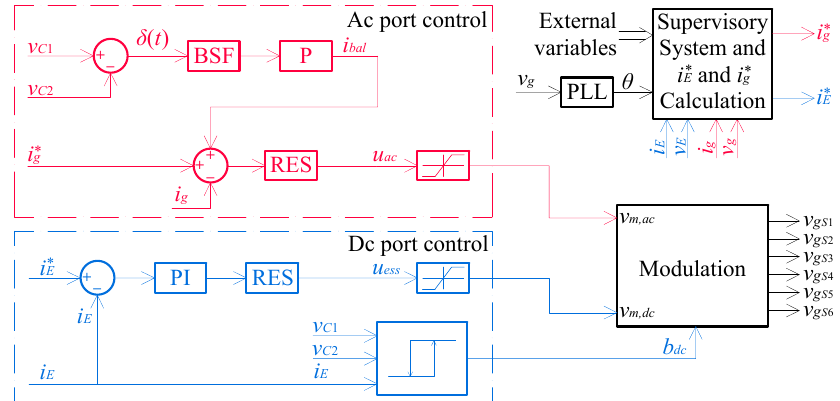
Figure 7. Control system block diagram. The control subsystems of the secondary DC and AC ports are represented in blue and red colors, respectively.